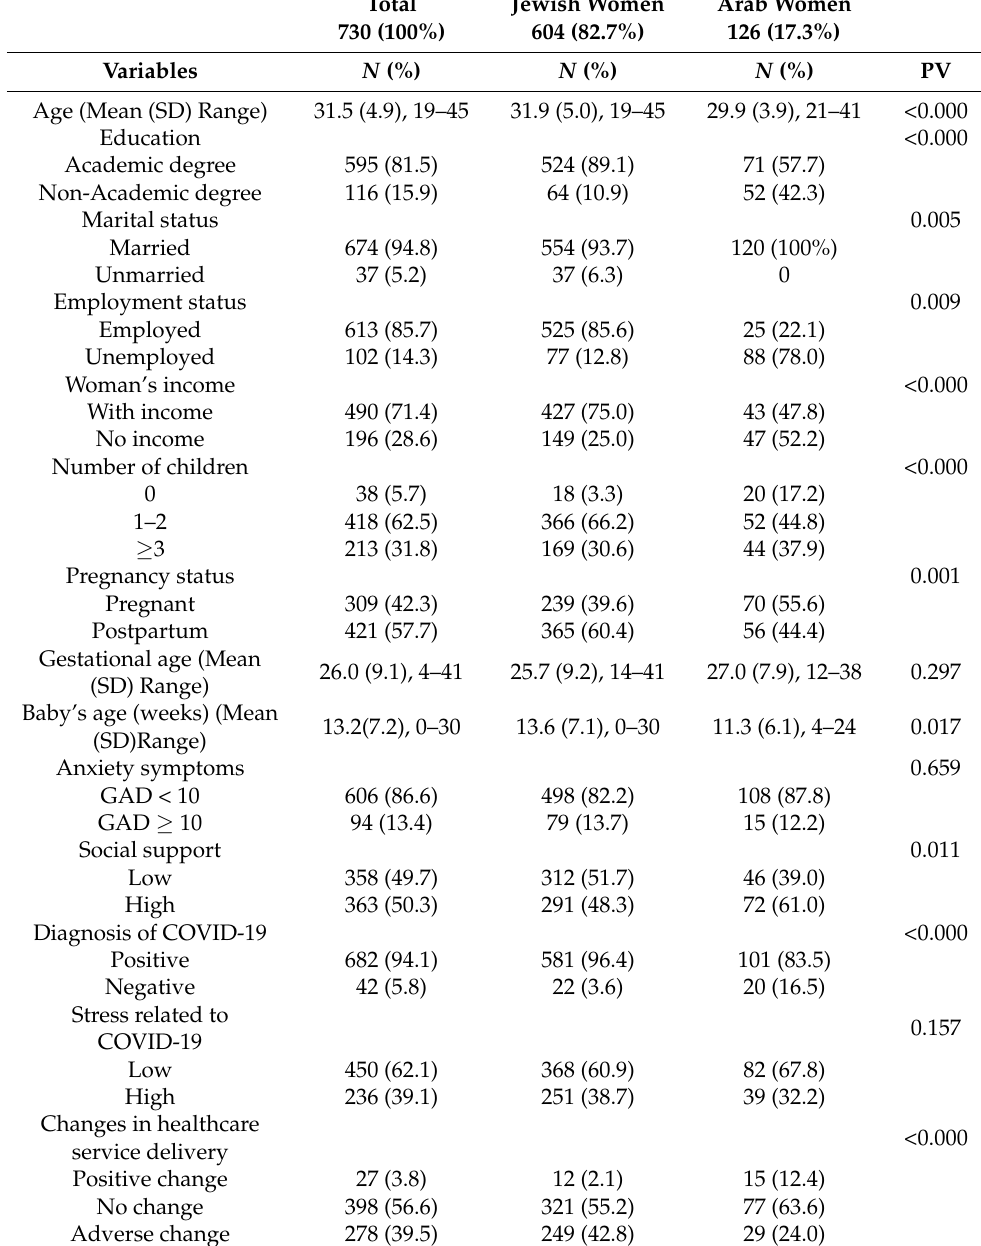
Table 1. Sociodemographic characteristics of Arab and Jewish women (Total N =